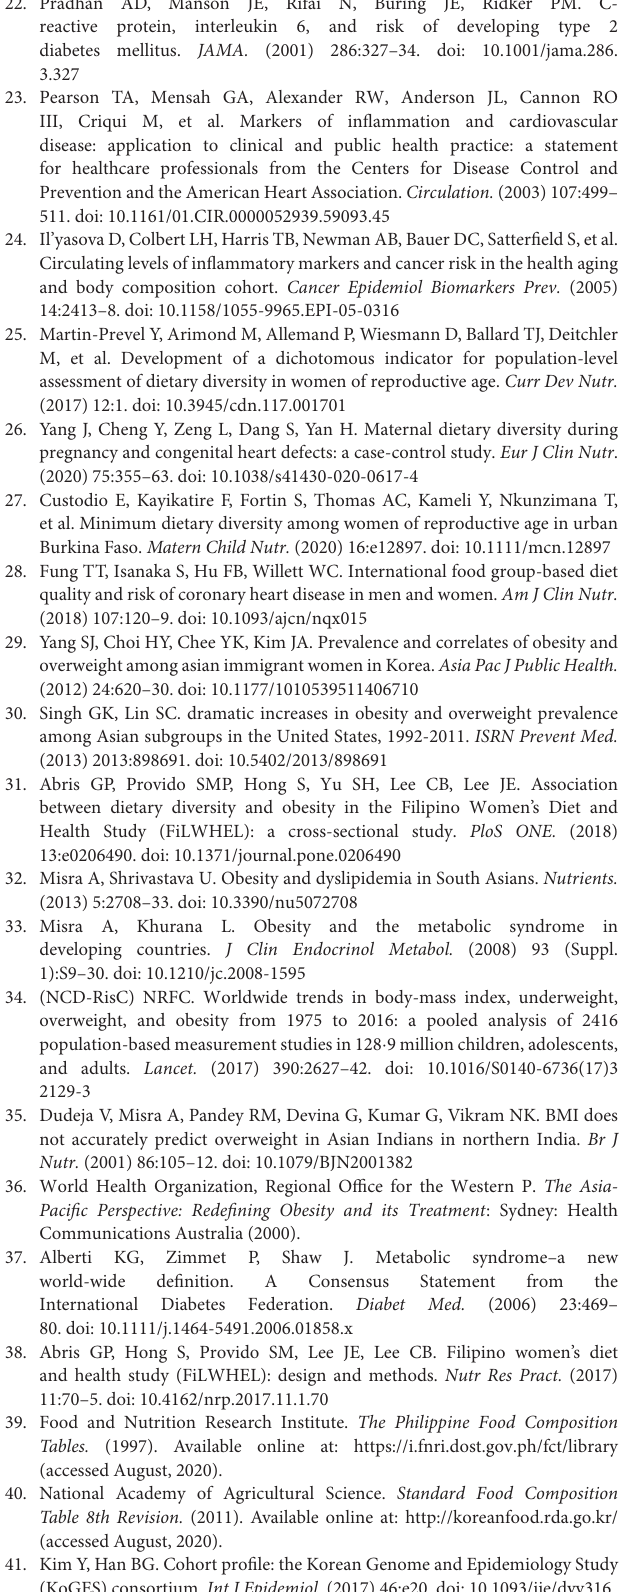
Table 8th Revision. (2011). Available online at: http://koreanfood.rda.go.kr/ (accessed August, 2020). 41. Kim Y, Han BG. Cohort profile: the Korean Genome and Epidemiology Study (KoGES) consortium. Int J Epidemiol. (2017) 46:e20. doi: